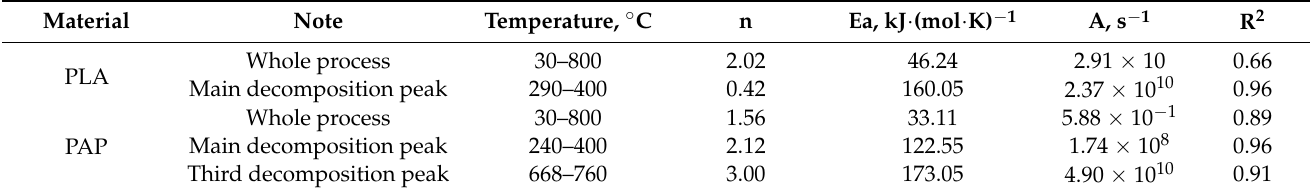
Table 2. Kinetic triplets determined at β = 10 ◦ C · min − 1 using Coats-Redfern method.